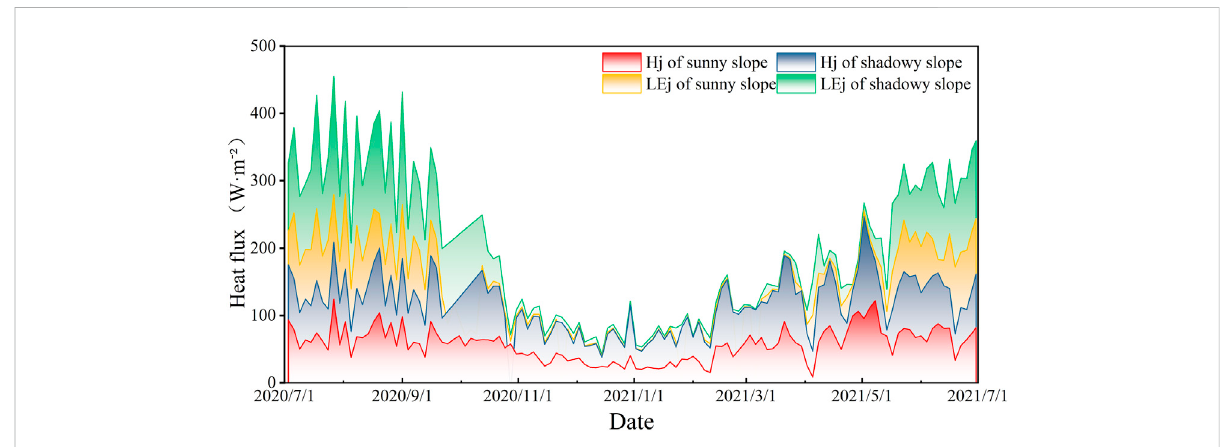
FIGURE 6 Variation characteristics of near surface sensible heat and latent heat fl uxes of shadowy and sunny slope (after